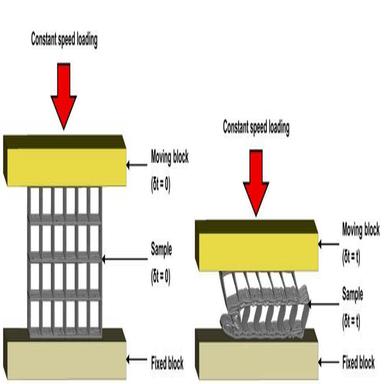
Simulation of the quasi-static compression test.